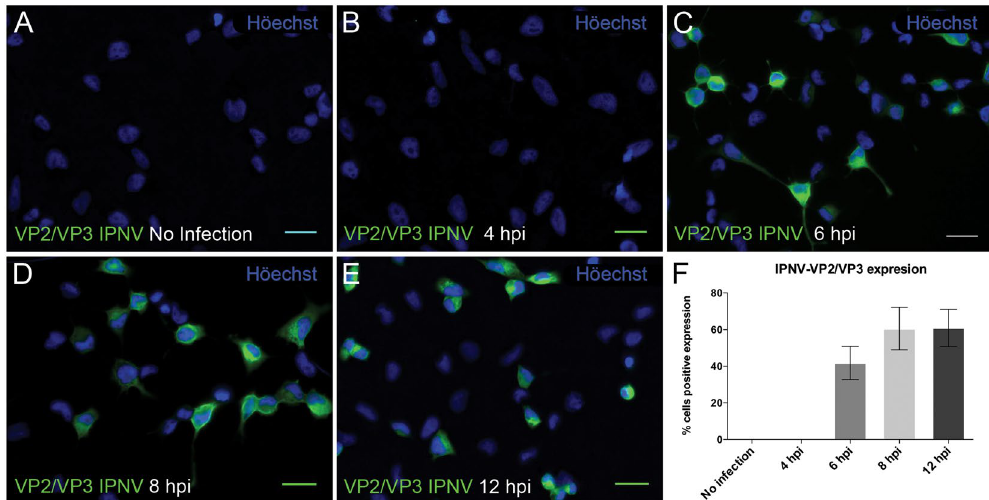
Figure 1. Timecourse of IPNV infection of CHSE-214 cells. VP2/VP3 expression was determined by immunofluorescence after 4 ( B ), 6 ( C ), 8 ( D ) and 12 ( E ) h post infection (hpi) in CHSE-214 cells. Cells were propagated at 60–70% confluence in 24-well plates with round glass coverslips. IPNV was inoculated at a MOI of 1 for 1 h. After 4, 6, 8 and 12 h of incubation at 20 °C, cells were processed by indirect immunofluorescence (IFI) using mouse oligoclonal anti-VP2/VP3 IPNV antibody and Alexa 488-conjugated donkey anti-mouse antibody. Representative images, recorded with an Olympus Spinning Disk IX81 microscope, are shown (bar scale = 20 μ m). At each incubation time, 250 cells were counted. Number of VP2/VP3-expressing cells is shown as a percentage, normalized to mock cells ( F